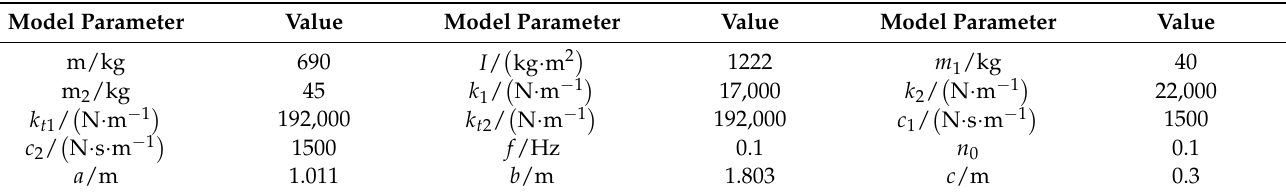
Table 1. Model parameters of semi-vehicle active suspension.